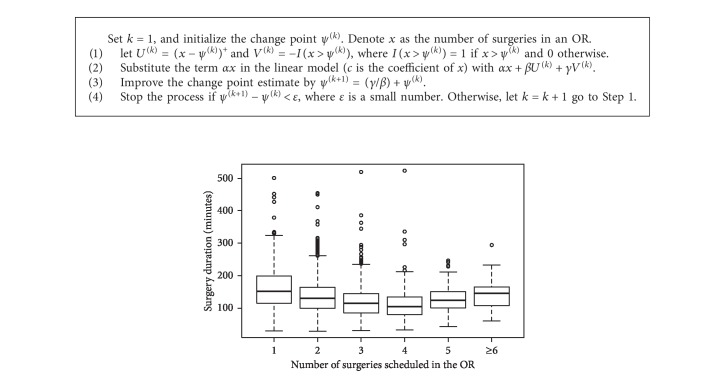
The box-plot about the relationship between operative duration and the number of surgeries in an OR. In the cases that there are four or fewer surgeries in an OR, the surgery duration decreases with the number of surgeries, while the duration increases if the number of surgeries in an OR is five or more.